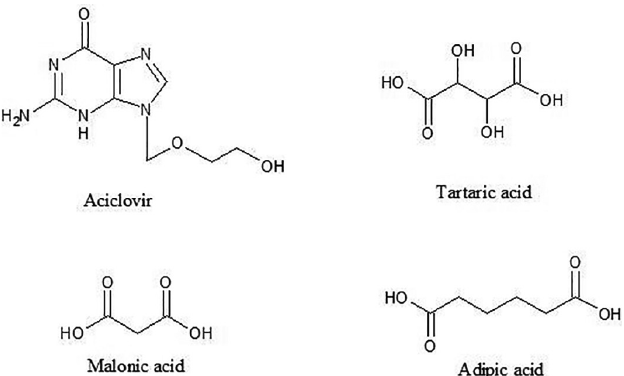
FIGURE 1 - Chemical structure of acyclovir and coformers used in the